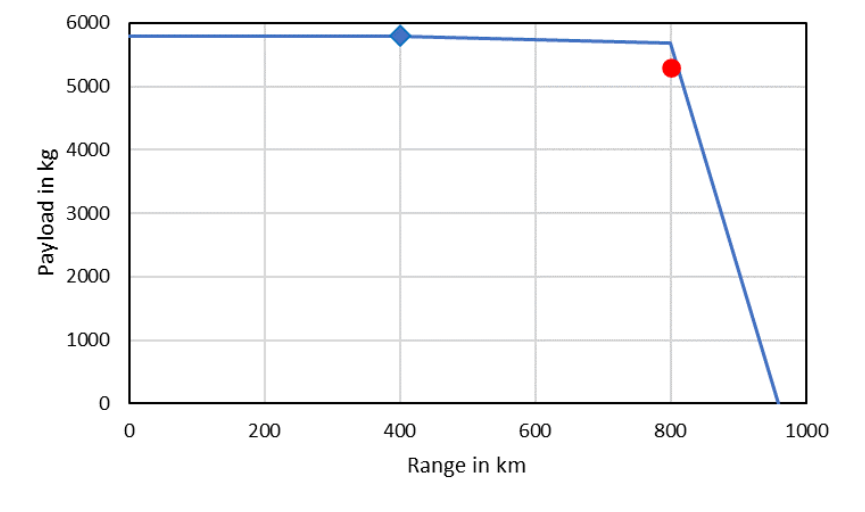
Figure 4. Payload-range diagram with design point (blue) and TLAR mission (red).